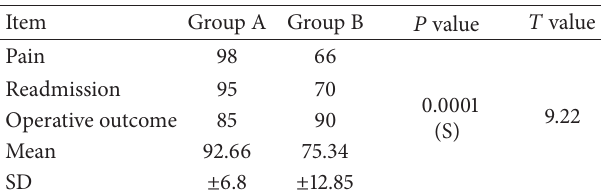
Table 3: Patient’s